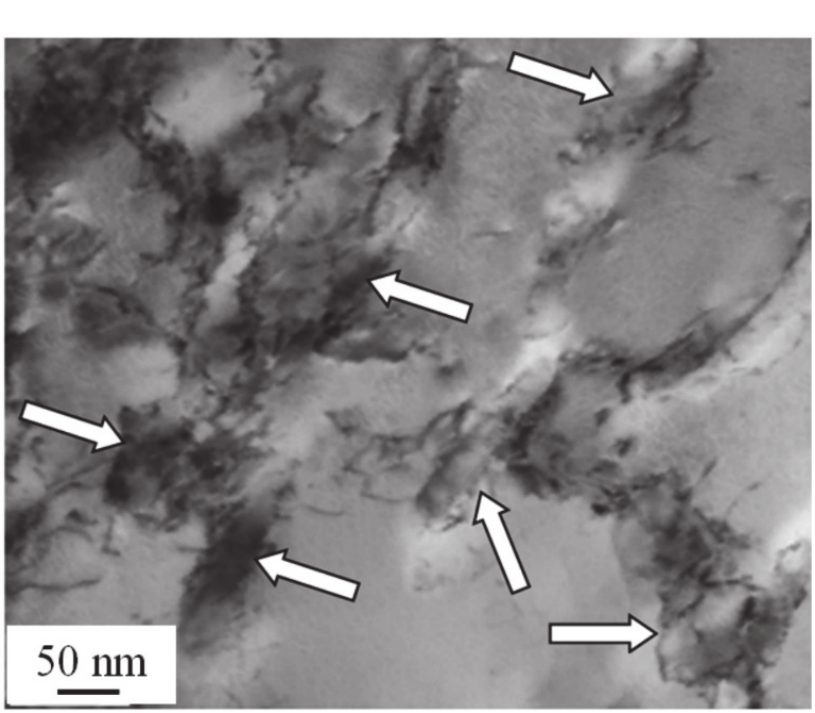
Figure 7. A TEM image of the dislocation substructure being formed near cementite particles (indicated by arrows) at ε = 50%.